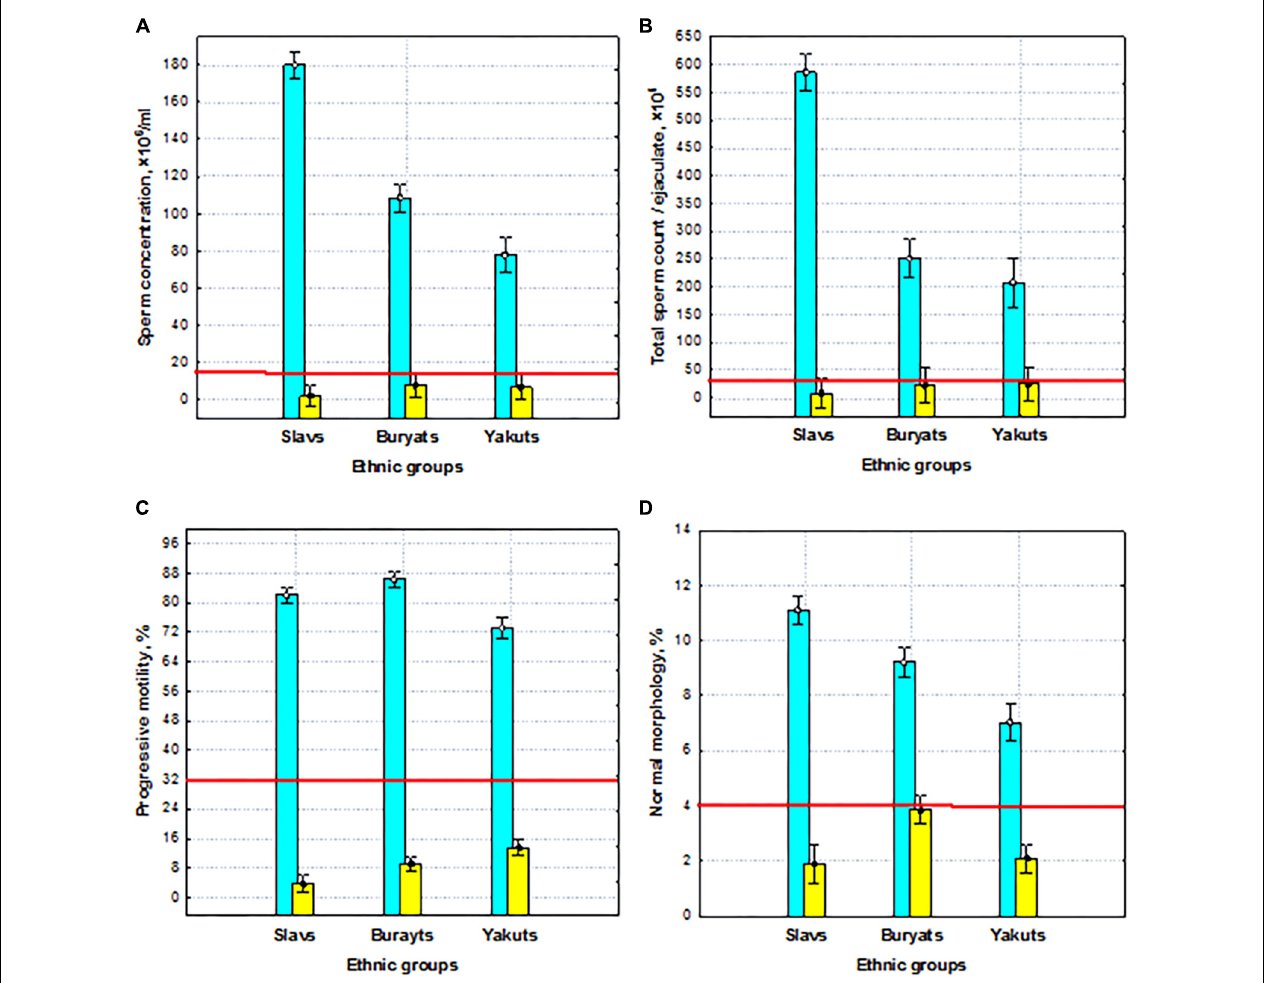
FIGURE 2 | Sperm quality (normospermia and pathozoospermia) and ethnic effects on semen quality parameters. (A) Sperm concentration, (B) total sperm count, (C) progressive sperm motility, and (D) normal sperm morphology in the preselected sample. Blue columns—normospermia, yellow columns—pathozoospermia. The red lines indicate the WHO reference limits for different normal semen parameters [World Health Organization (WHO),